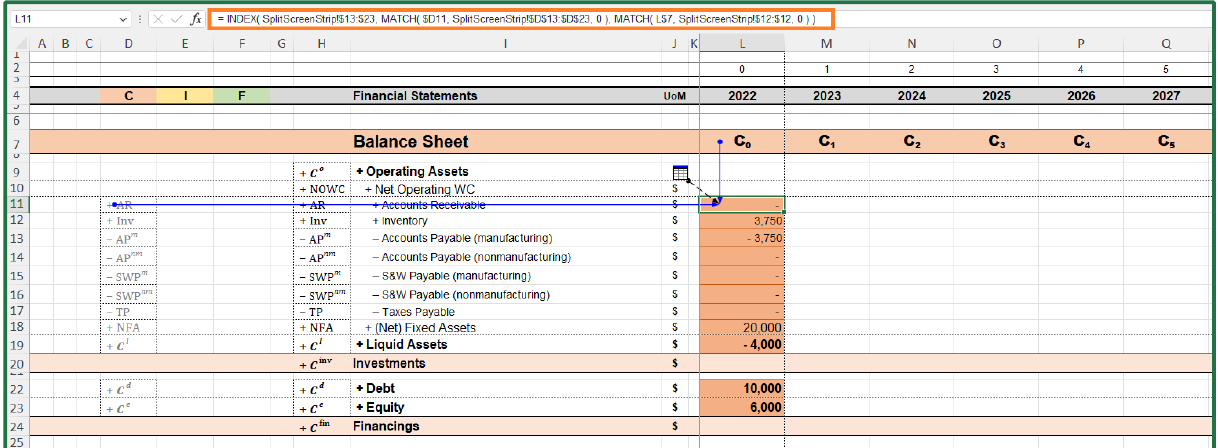
Figure 51. Cell L11 contains the formula for picking the Account Receivables ( +AR ) of period 𝑡 =0 from the split-screen strip (“ConventionalFinStat” sheet).